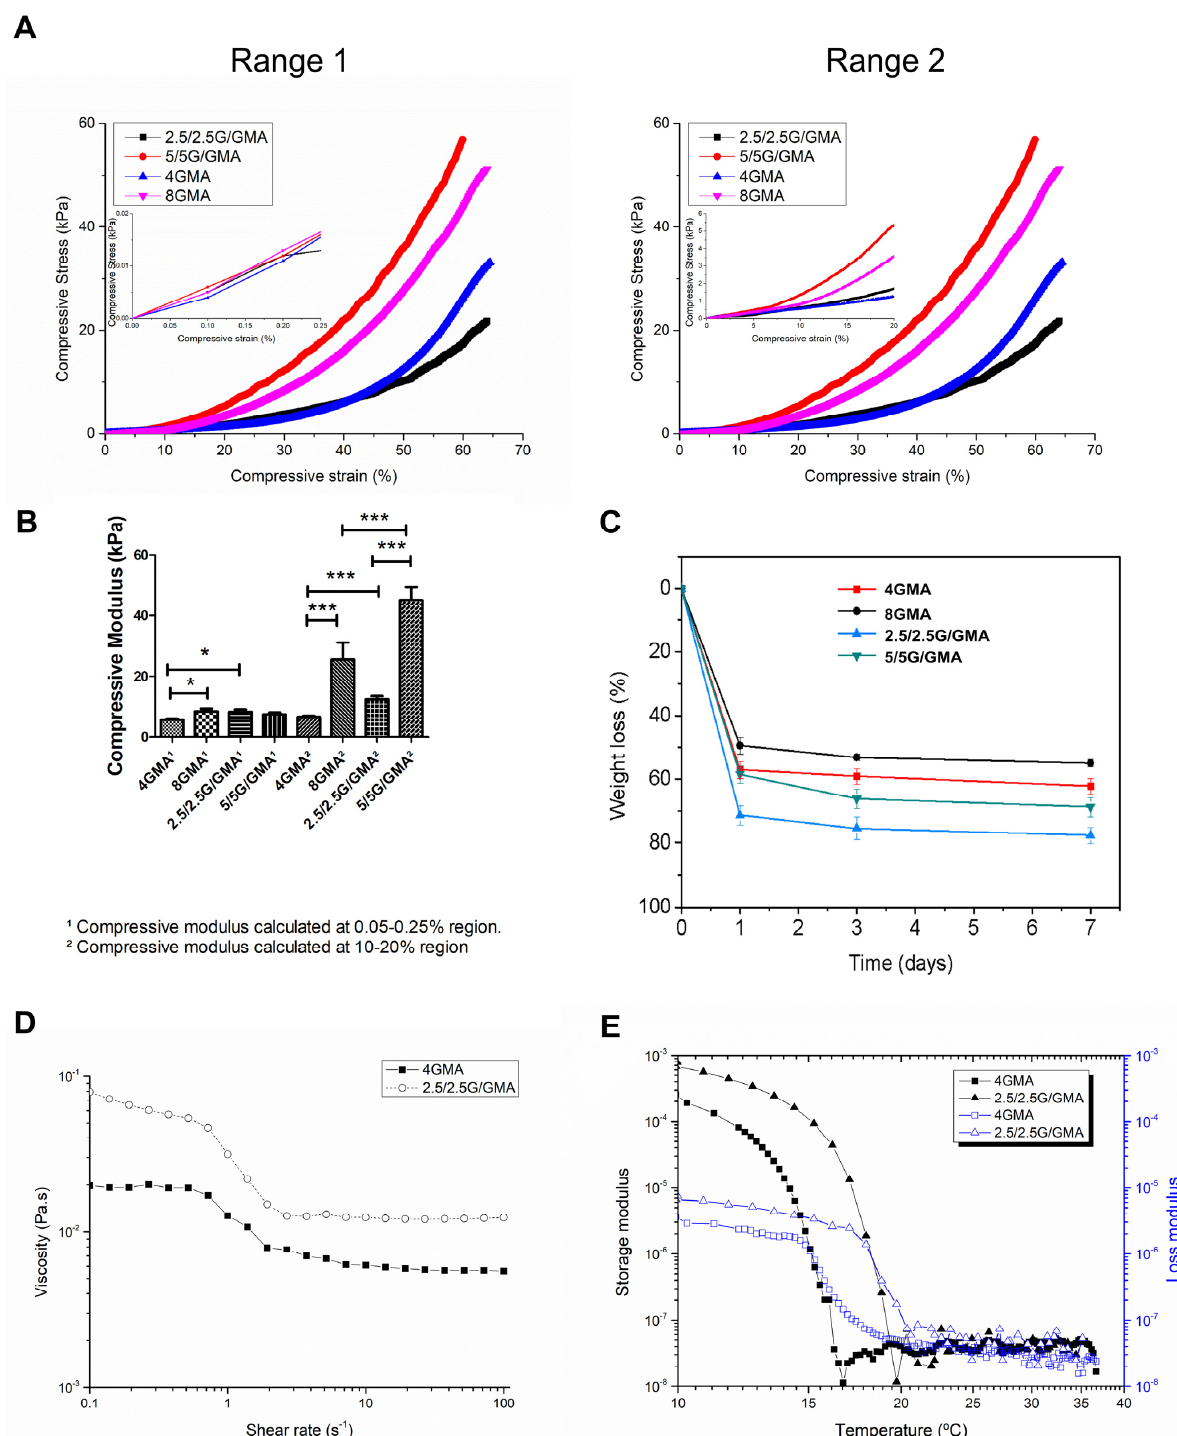
Figure 1. Mechanical and rheological properties of the bioink. Mechanical properties of the bioink under compressive loading (Range 1: zoom of the 0.05–0.25% region, Range 2: zoom of the 10–20% region) ( A ). Compressive moduli of the bioink under compressive loading ( B ). Bioink degradation ( C ). Viscosity versus shear rate for the bioink analyzed at 25 °C ( D ). Storage and Loss moduli versus temperature for the bioink analyzed ( E ). * = p < 0.05, *** = p < 0.005, one-way Anova plus Tukey post hoc